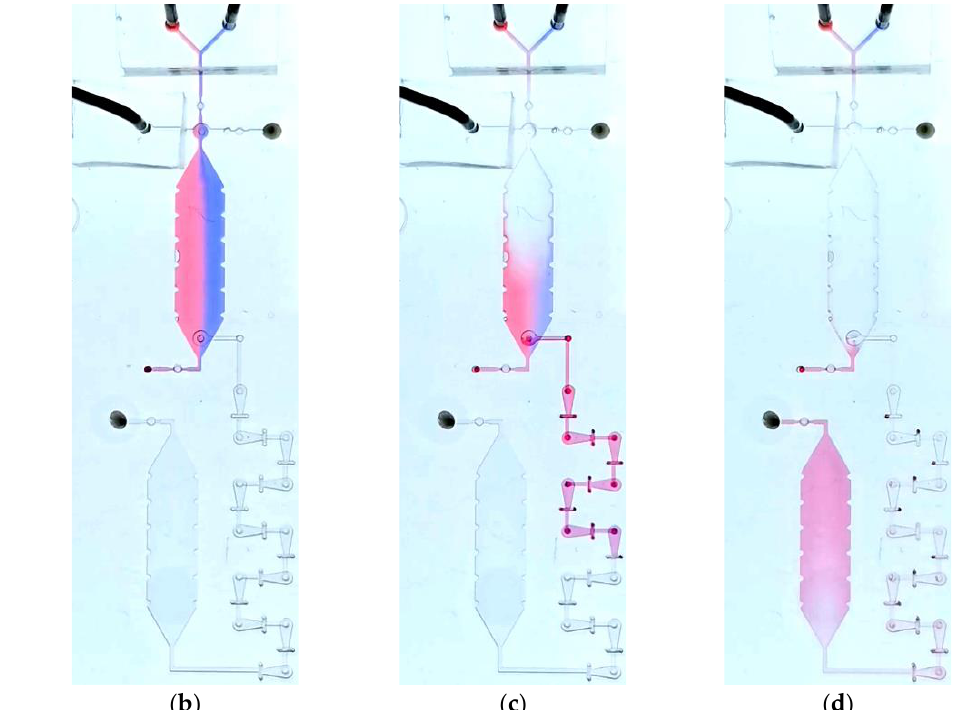
Figure 12. The chemofluidic application chip executes the circuit program. ( a ) An unfilled chip ready for operation showing the order of building elements. ( b ) Liquid 1 (red ink-stained water) and liquid 2 (blue ink-stained water) are simultaneously pumped into VDC at a constant pressure of 50 mbar and a flow rate of 40 – 45 µL/min. ( c ) Transportation of the two liquids by liquid 3 (unstained water) through M into CC ( d ).